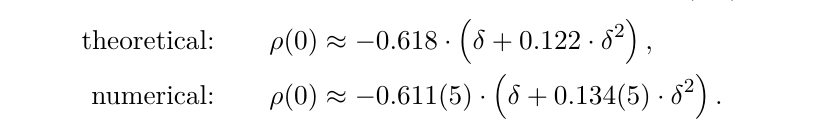
Figure 7 . Extrapolation of the transition-point location g ∗ (1 , 0 . 1) . Blue data points have even N , orange data points have odd N , and red data points are generated by the eigenvalue-flipping algorithm. The green fit in the bottom-left plot goes through both blue and orange points since they do not seem to belong to separate groups at this